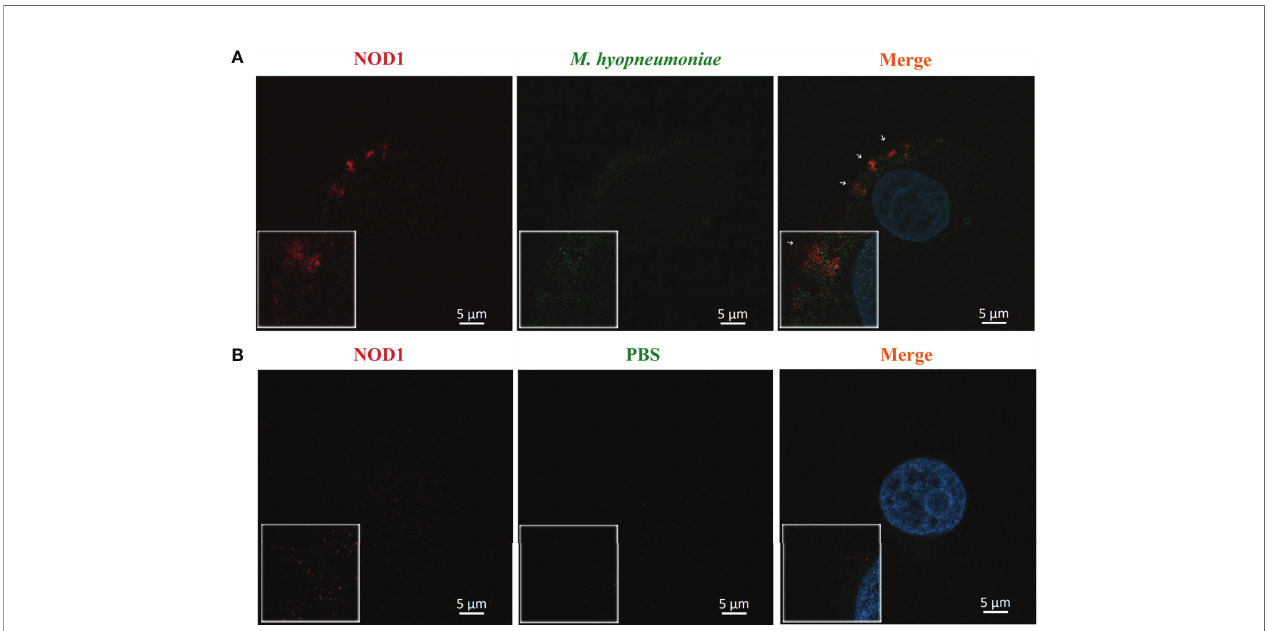
FIGURE 5 | Confocal laser scanning micrograph for the adhesion of M. hyopneumoniae cells to alveolar macrophages. Alveolar macrophages were treated with M. hyopneumoniae (A) and PBS (B) , respectively. M. hyopneumoniae cells were labeled with CFDA-SE (green); cell nuclei were stained with DAPI (blue); and NOD1 was labeled red by using mouse anti-NOD1 mAb and goat anti-mouse IgG-Cy3. M. hyopneumoniae cells were adhered to the edges of alveolar macrophages, presenting a merged yellow signal, where M. hyopneumoniae was co-localized with the cellular NOD1 (white arrows). Scale bars = 5 µm.